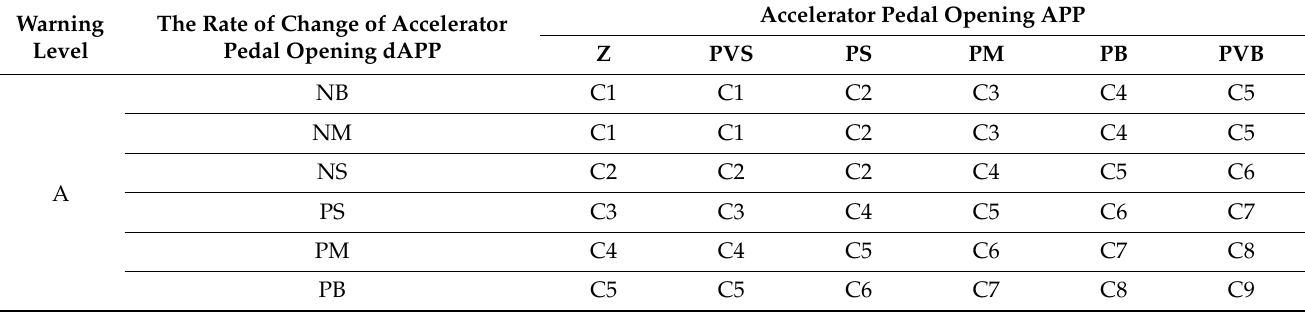
Table 1. Fuzzy rules for driving mode